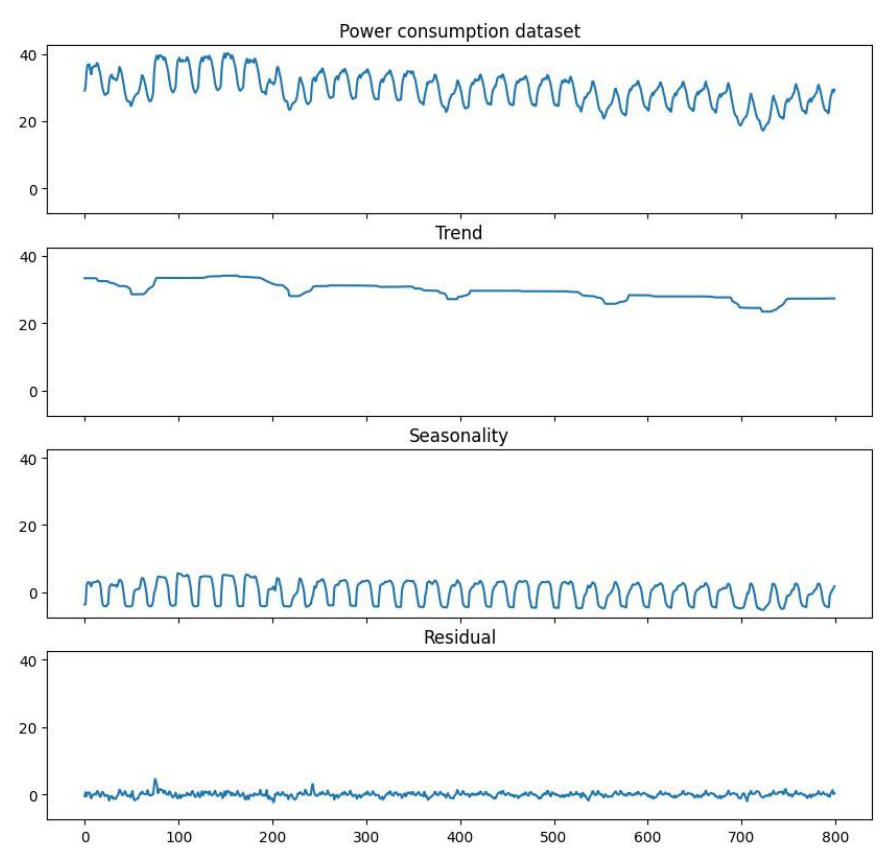
Figure 5. The decomposition results.